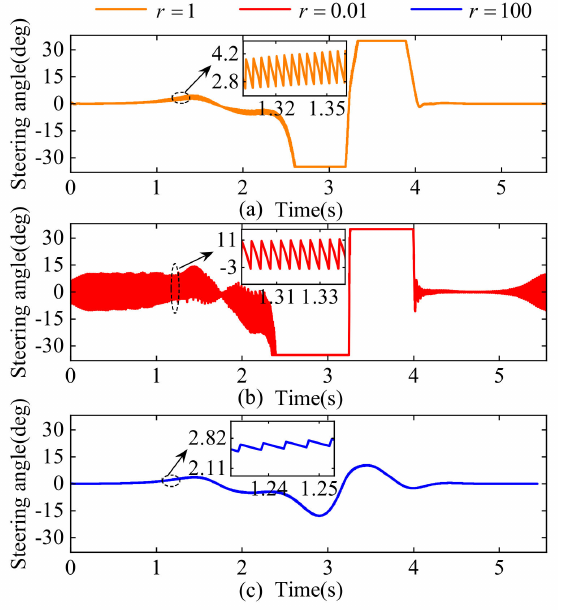
Figure 9. Response of the steering angle under different weight coefficients of r .